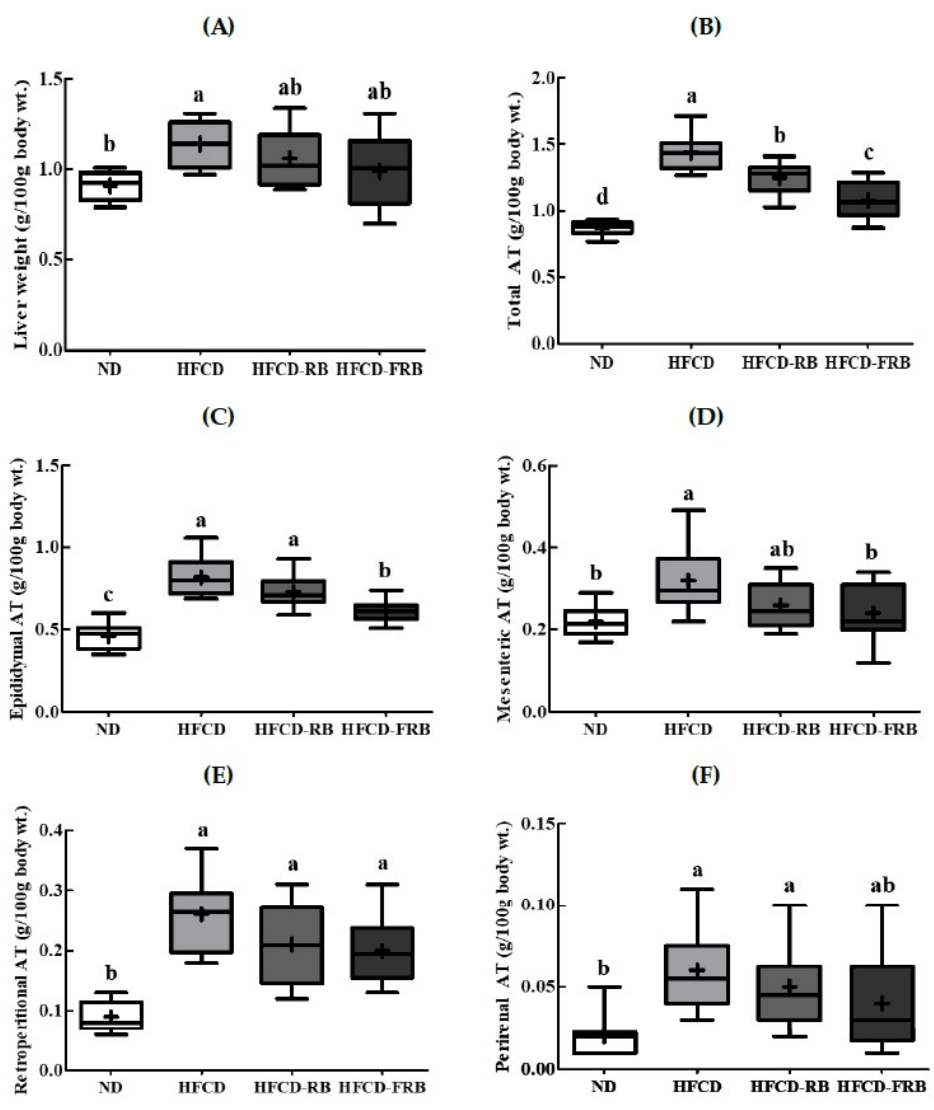
Figure 2. Relative hepatic tissue and white adipose tissue weight in mice fed experimental diets for 10 weeks. Diet groups: ND, normal diet group; HFCD, high-fat and -cholesterol diet group; HFD-RB, HFCD + non-fermented rice bran powder group; HFCD-FCA, HFCD + fermented rice bran powder group. Relative ( A ) hepatic tissue, ( B ) total white adipose tissue (total WAT), ( C ) epididymal adipose tissue (EAT), ( D ) mesenteric adipose tissue (MAT), ( E ) retroperitoneal adipose tissue (RAT), and ( F ) perirenal adipose tissue (PAT). Relative tissue weights (%) were calculated as organ weight (g)/final BW × 100. Values are displayed as a Box-and-Whisker plot with means (expressed as ‘+’), n = 10. a-d: bars with different letters are significantly different at p < 0.05 by Tukey’s post hoc